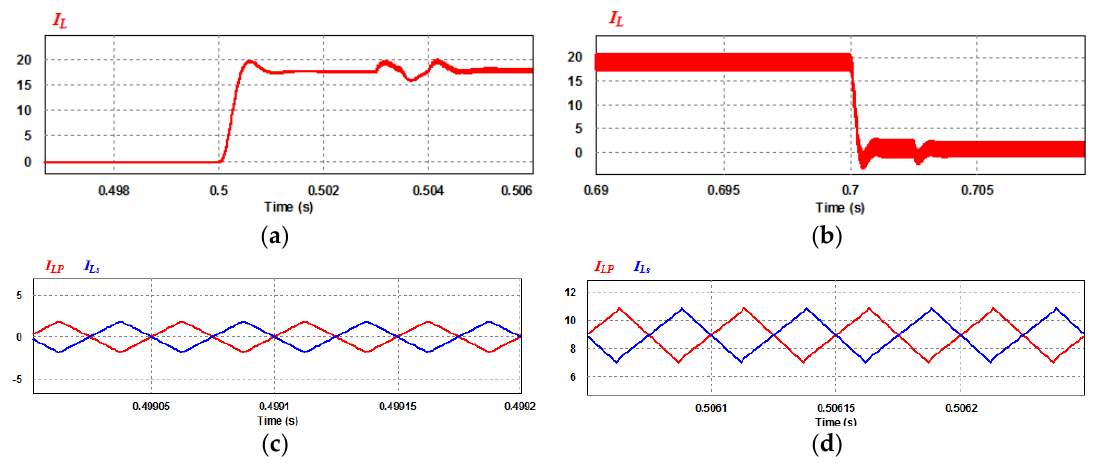
Table 3. Load variation conditions. Figure 9. Simulation waveforms of inductor currents: ( a ) Waveforms of total inductor currents at unbalanced load (increased load), ( b ) waveforms of total inductor currents at unbalanced load (decreased load), ( c ) enlarged waveforms under balanced load, ( d ) enlarged waveforms under unbalanced load.